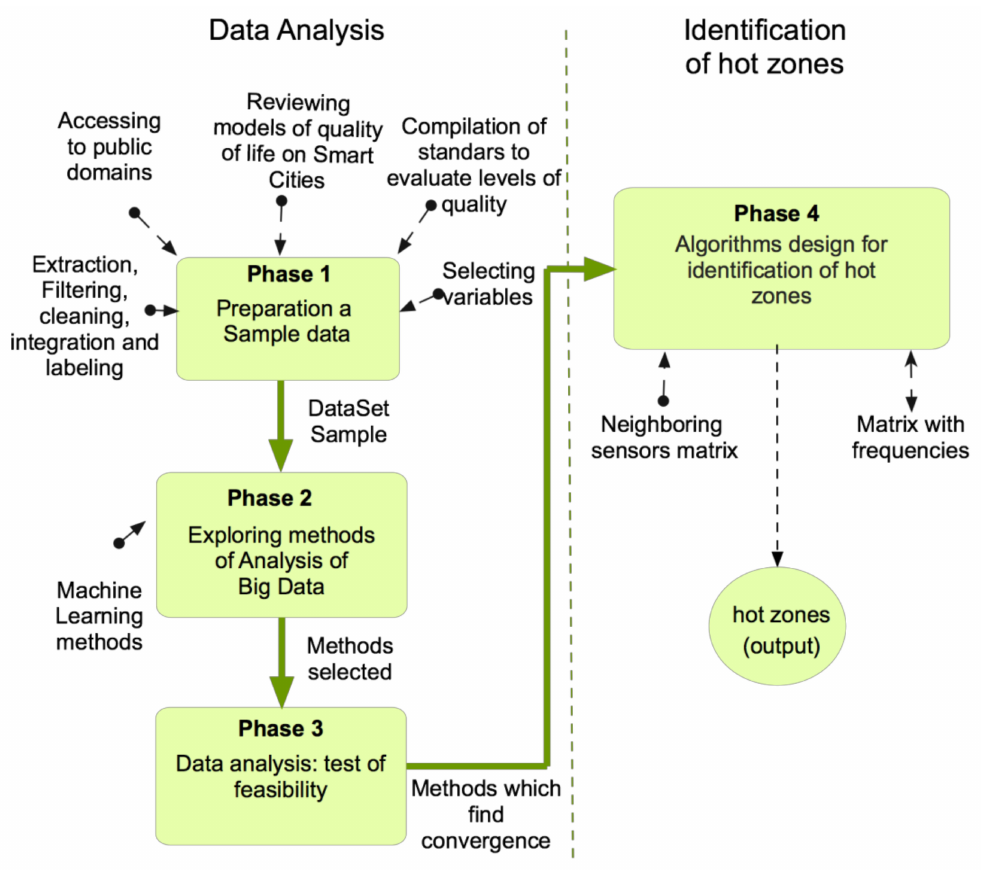
Figure 2. Phases of the proposed process that determine a scheme to design algorithms to place sensors in specific